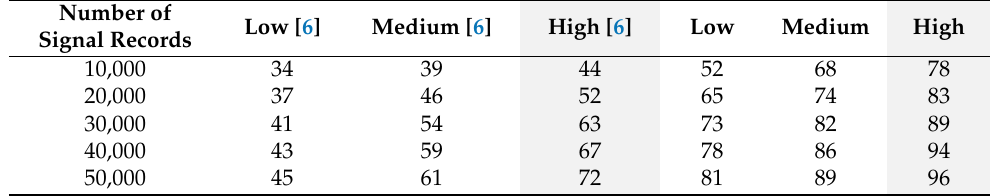
Table 2. Variation of signal strength.